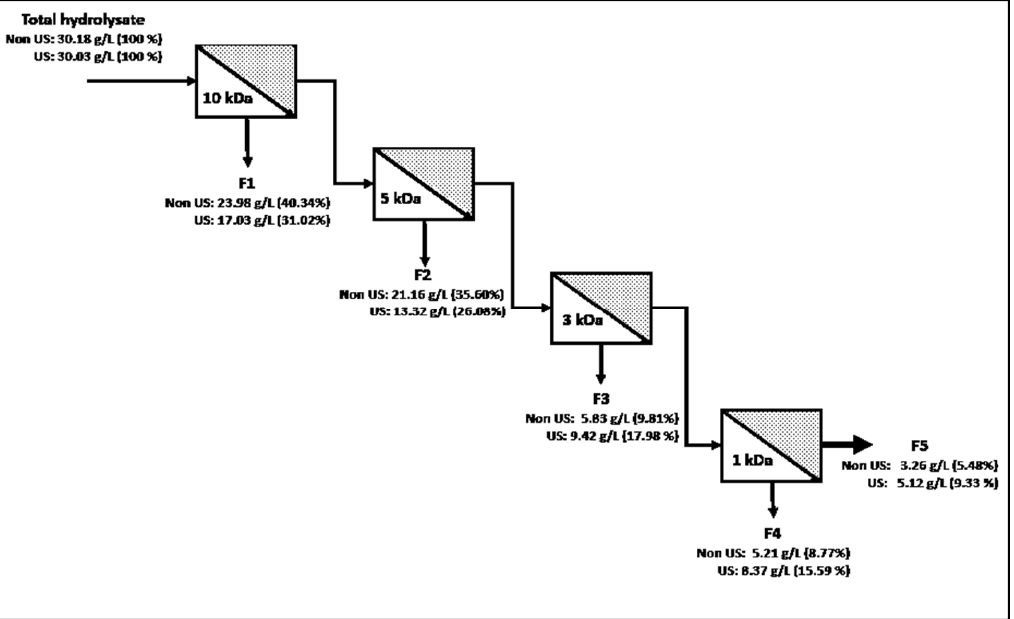
Figure 2. Flow chart of membrane fractionation of WPI hydrolysate and the protein concentration of each associated membrane fraction.